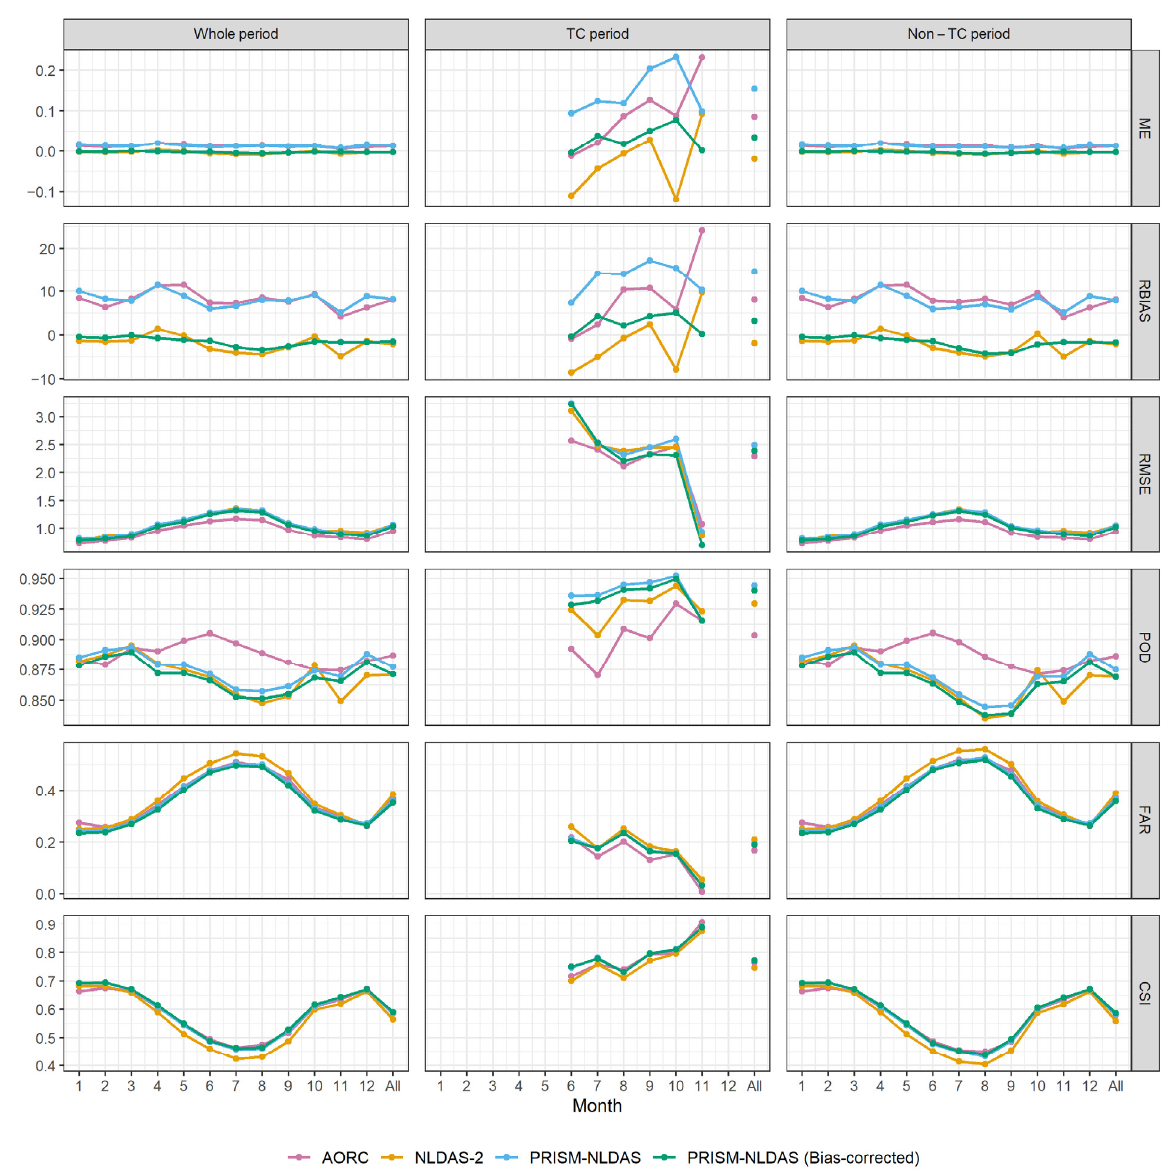
Figure 4. Error metrics (mean error, relative bias, and root mean square error) and contingency metrics (POD, FAR, and CSI) of gridded hourly rainfall products depending on months for the whole, TC, and non-TC periods. In the top three rows, values closer to zero are preferable. Larger values are preferable in the fourth and sixth rows, while smaller values are preferable in the fifth row.